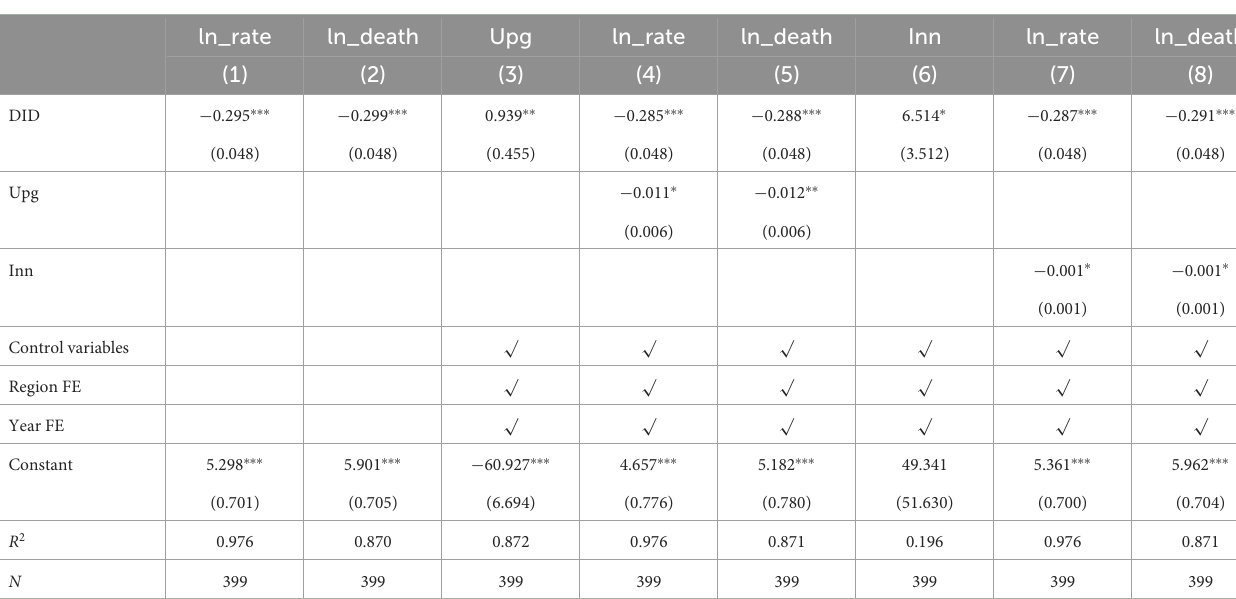
TABLE 8 Mediation effect